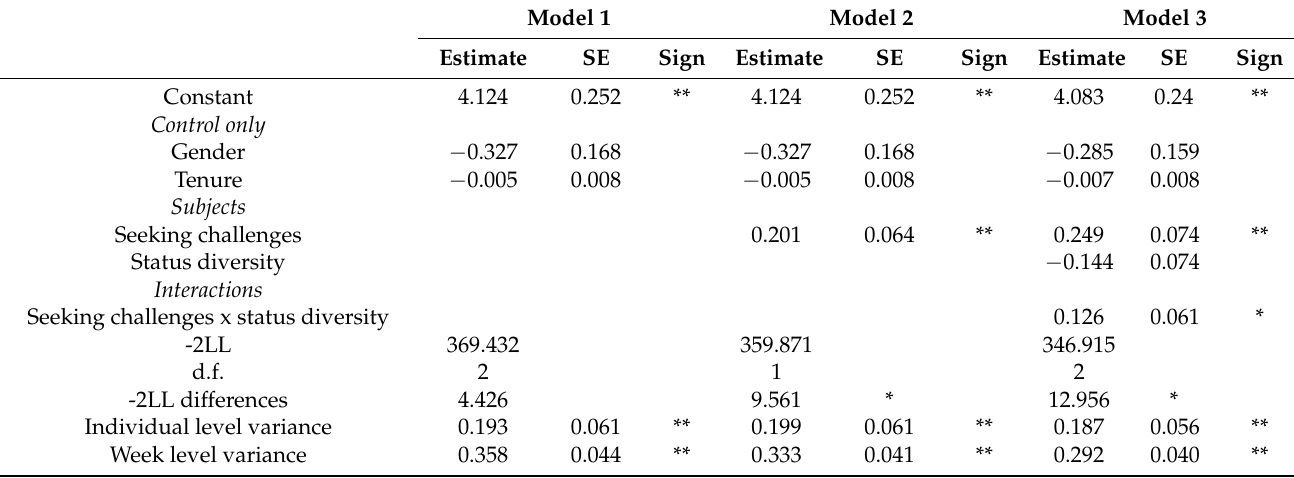
Table 4. Multilevel estimates of weekly seeking challenges, perceived work group member status diversity on weekly creativity.